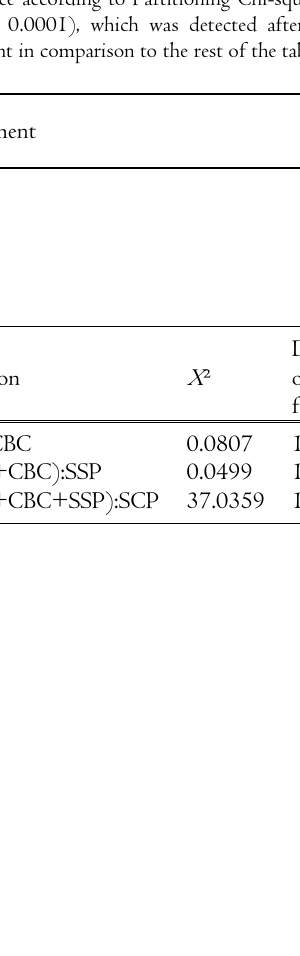
T ABLE 4. Comparison between the percentages of fruit Comparison between the percentages of resulting from manual pollination experiments in a greenhouse.